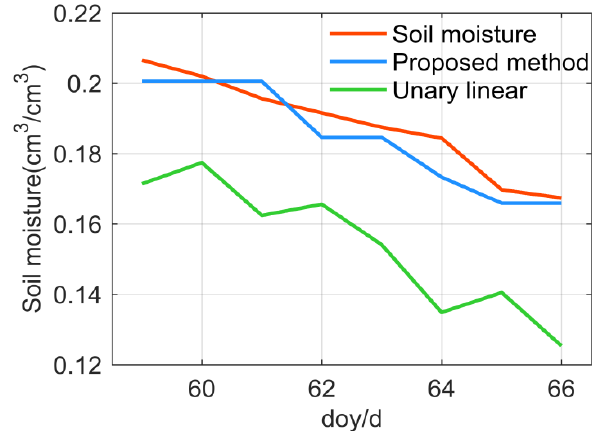
Figure 10. Retrieval results of Henan experiment.